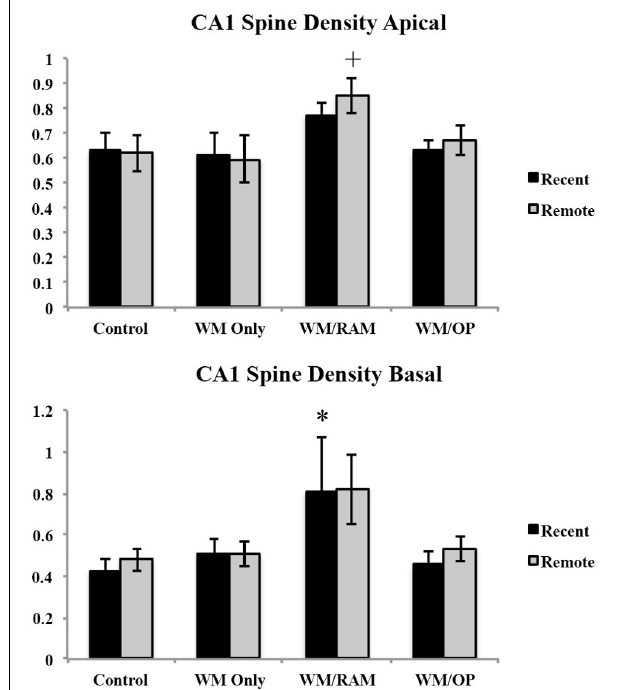
FIGURE 11 | Total number of spines in the ACC in apical and basal dendrites. Only significant differences between behavioral groups and their respective control group are displayed. Refer to Results section for all comparison results. ∗ Significantly different from Control:recent group ( p < 0 . 05); + Significantly different from Control:Remote ( p < 0 . 05).